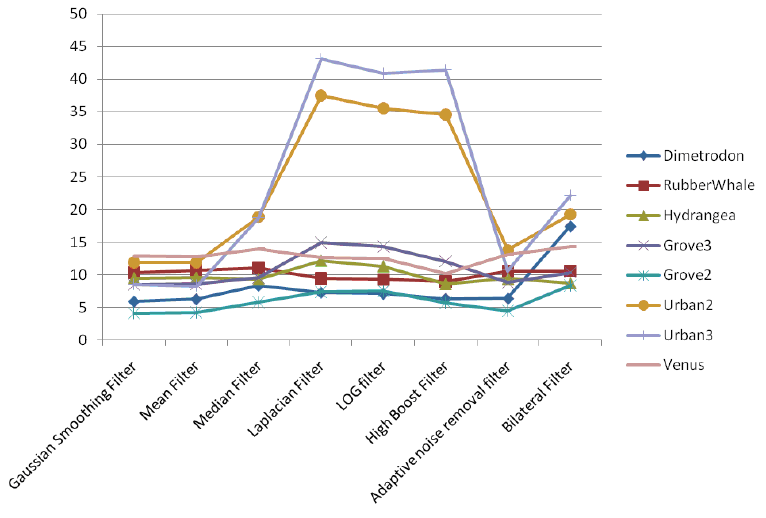
Figure 7. Average angular errors obtained using different filters on all resized images.